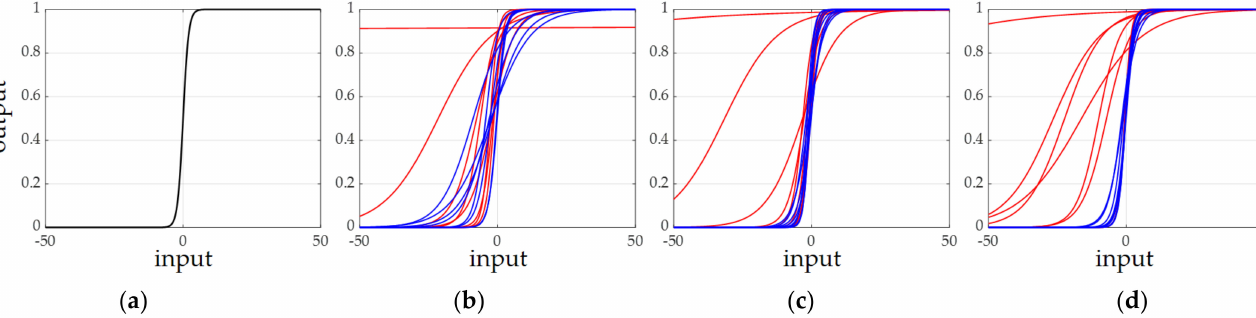
Figure 10. Shapes of the original sigmoid and the parametric sigmoids for the test image of BMP2 input to the DS-AE network learned by 25% of MSTAR training images. The red and blue correspond to the parametric sigmoids of channels with strong and weak responses, respectively. ( a ) Original sigmoid; ( b ) parametric sigmoids of stage 1 in the basic CNN; ( c ) parametric sigmoids of stage 2 in the basic CNN; ( d ) parametric sigmoids of stage 3 in the basic